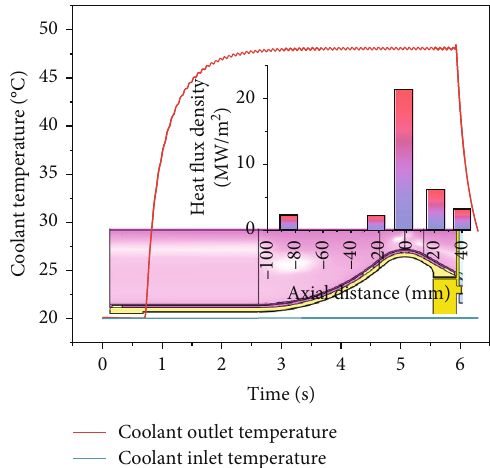
Figure 10: The diagram of the thrust chamber cooling and the nozzle heat exchange.